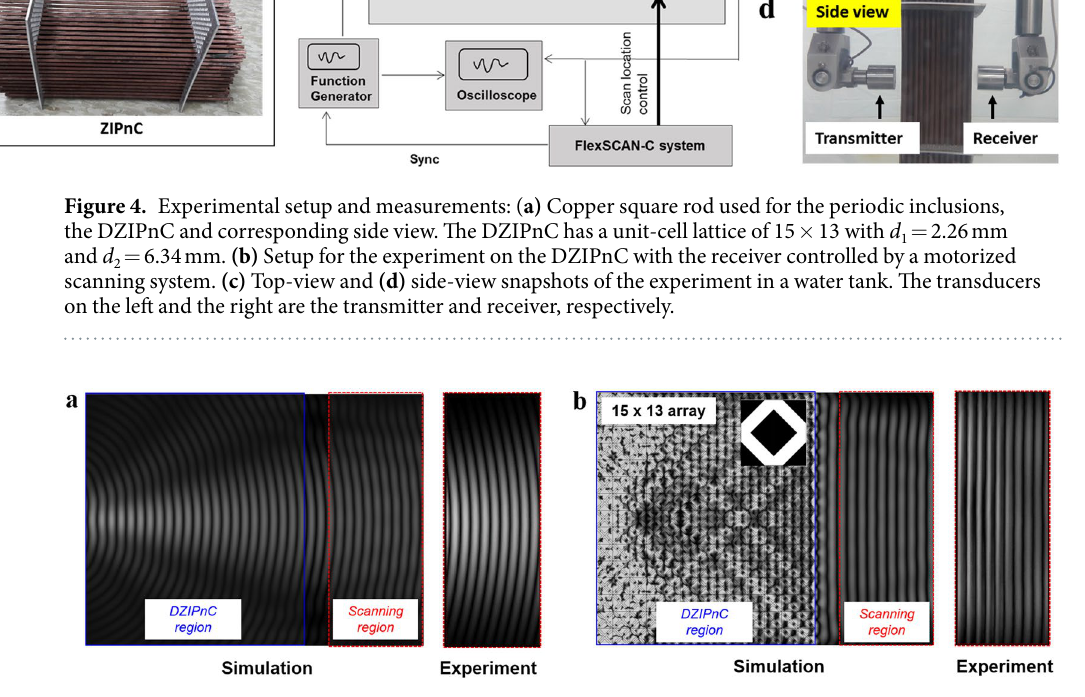
Figure 5. Absolute value of pressure fields simulated and measured: ( a) without and (b) with the DZIPnC. Whereas curved responses are apparent without the crystal, the simulation and experimental results show collimated waves with the